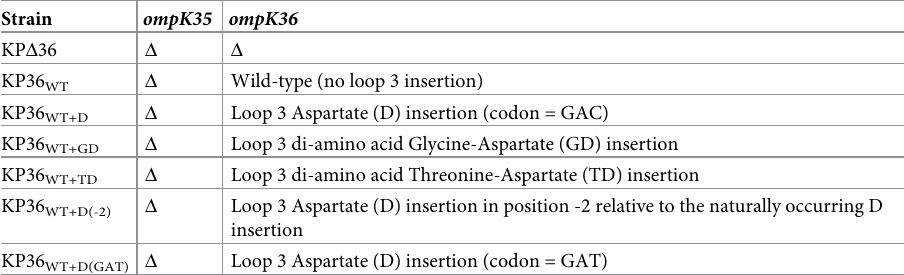
Table 1. Isogenic strains used in this study. The parental strain ICC8001 [16] was genetically modified in a seamless and markerless recombineering approach to generate the ompK36 variants.